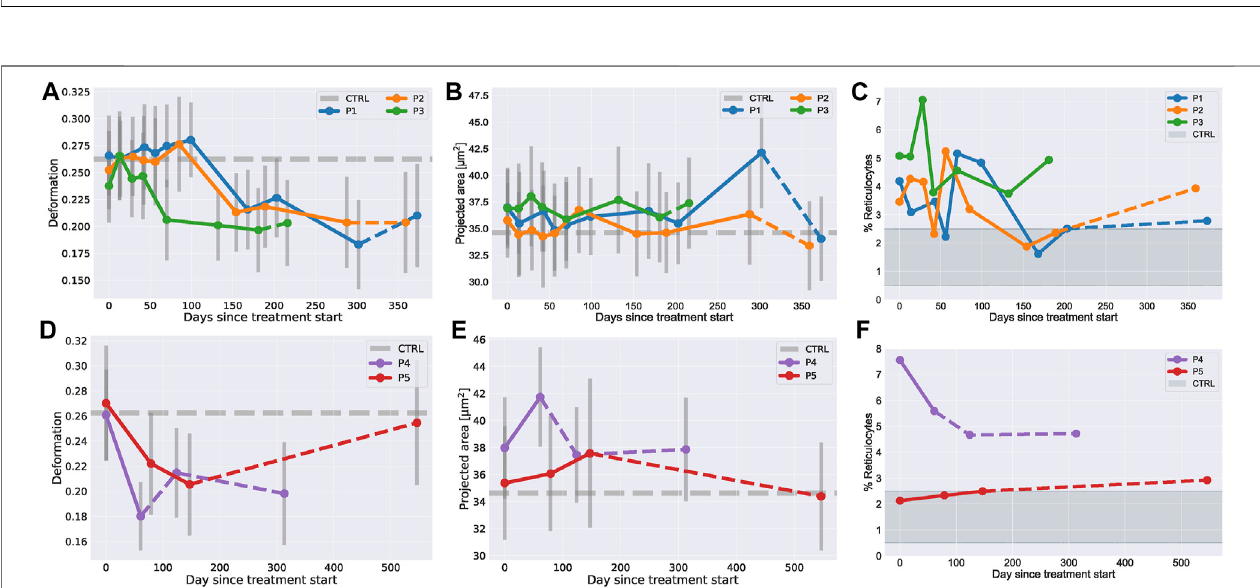
FIGURE4| RBCdeformation,sizeandreticulocytecountinRT-FDCduringtreatmentwithdasatiniborlithium. (A-C) RBCmediandeformation,projectedareaand reticulocyte fraction measured with RT-FDC before, during and after treatment with dasatinib. (D-F) RBC median deformation, projected area and reticulocyte fraction measured with RT-FDC before, during and after treatment with lithium. Dashed lines indicate time points after the treatment was stopped, dashed gray lines indicate control values without treatment. The red region in the reticulocyte plots indicates the range for healthy individuals reported in the literature of 0.5 – 2.5%.